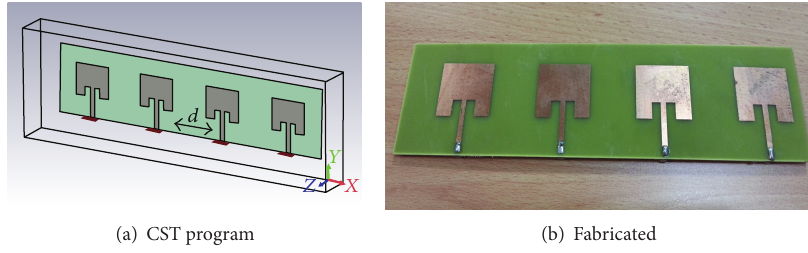
Figure 2: (a, b) Four elements of the linear